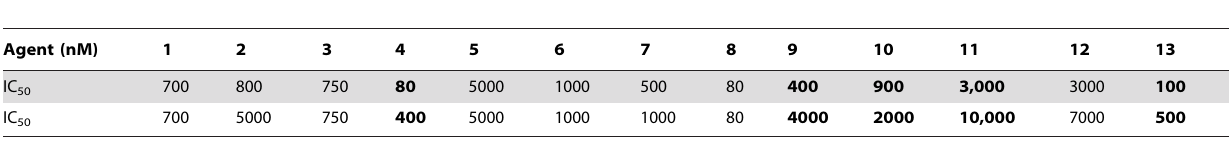
Table 1. IC 50 (nM) for APP 5 9 UTR blockers in pIRES-APP-5 9 UTR transfectants (top row) and pIRES-PrP-5 9 UTR transfectants (bottom